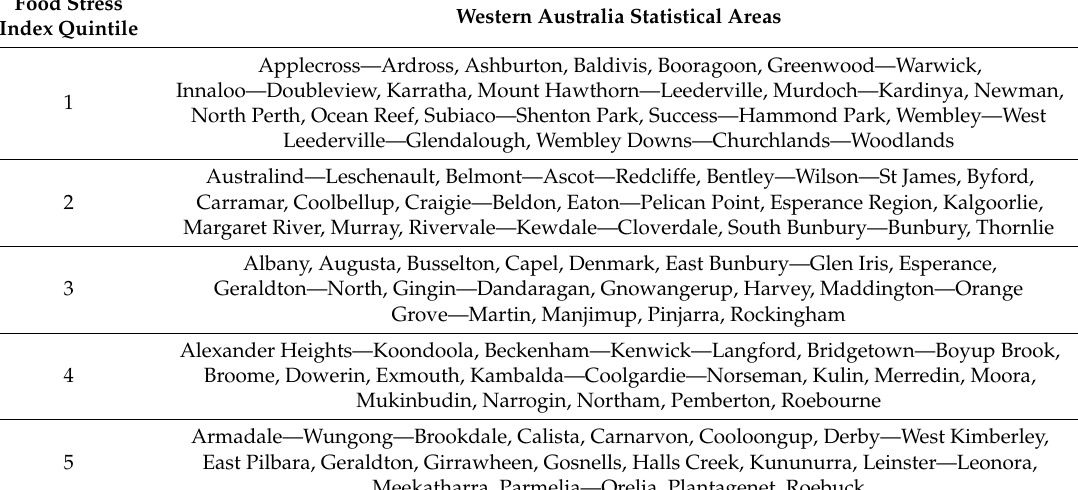
Table 3. Food Stress Index for Statistical Areas in Western Australia by quintile, ranging from 1 (least likelihood of food stress) to 5 (most likelihood of food